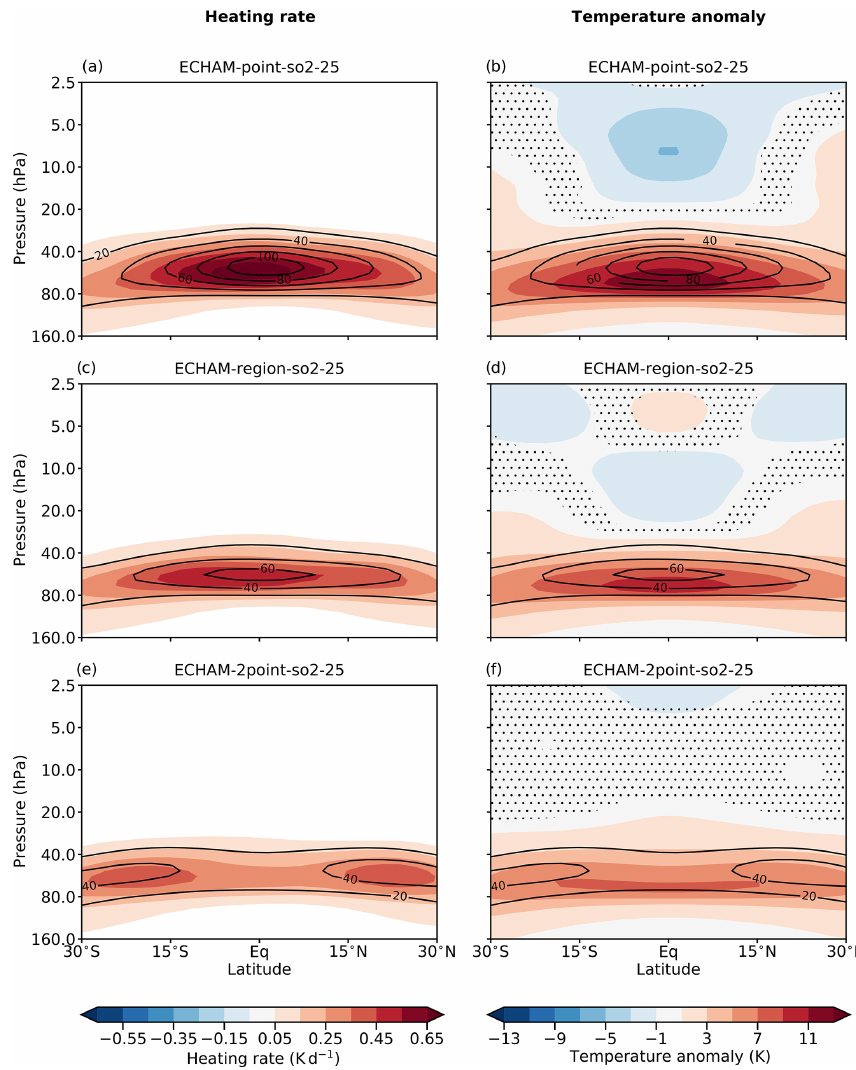
Figure 2. Latitude–height cross section of the zonal mean net aerosol heating rate (a, c, e) and of the anomaly of the zonal mean temperature T (b, d, f) for the ECHAM simulations of point-so2-25 (a, b) , region-so2-25 (c, d) , and 2point-so2-25 (e, f) . Stippling indicates areas where the temperature anomalies are not significant at the 95% level in Student’s t test. Black contour lines indicate the anomaly of the zonal mean sulfate mass mixing ratio m SO in intervals of 20µg ( S ) kg − 1 4